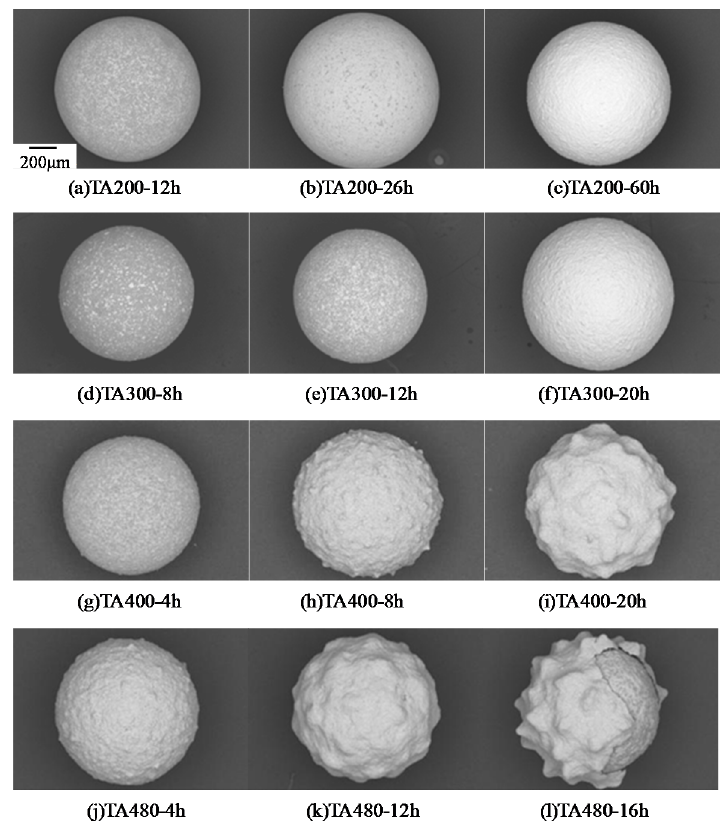
Figure 17. SEM images of the surface of the samples.